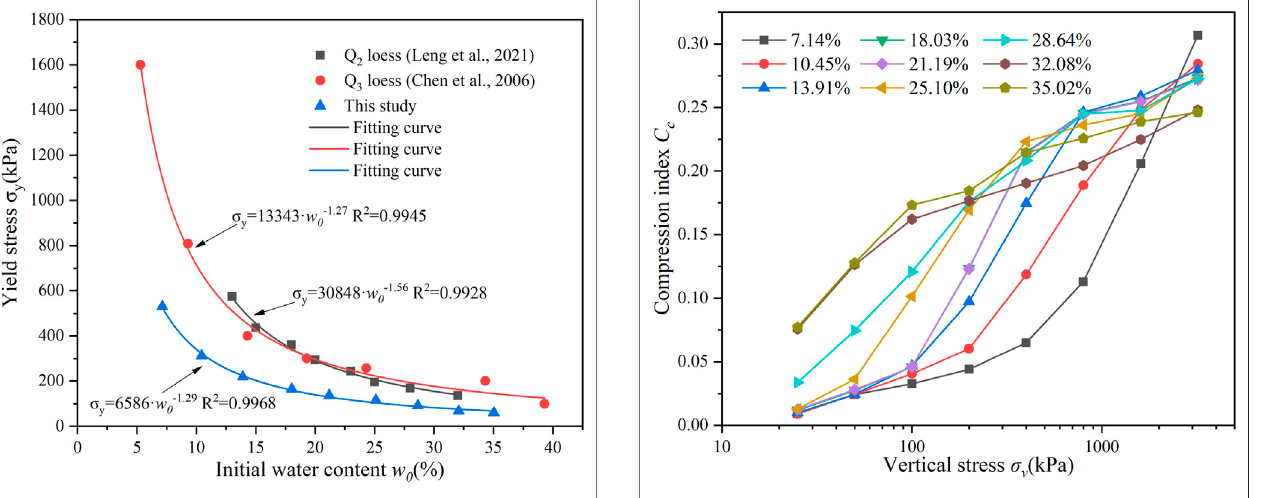
FIGURE 5 | Relationships between yield stress and initial water content of intact loess.